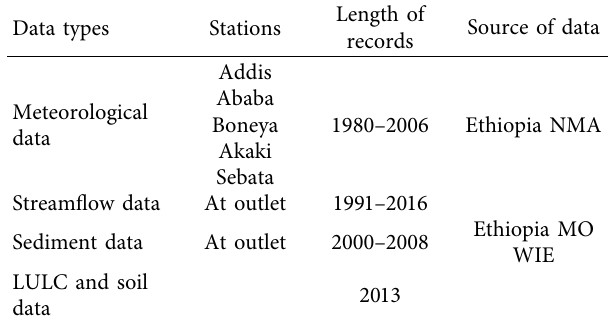
Table 1: Input data, their sources, and lengths of